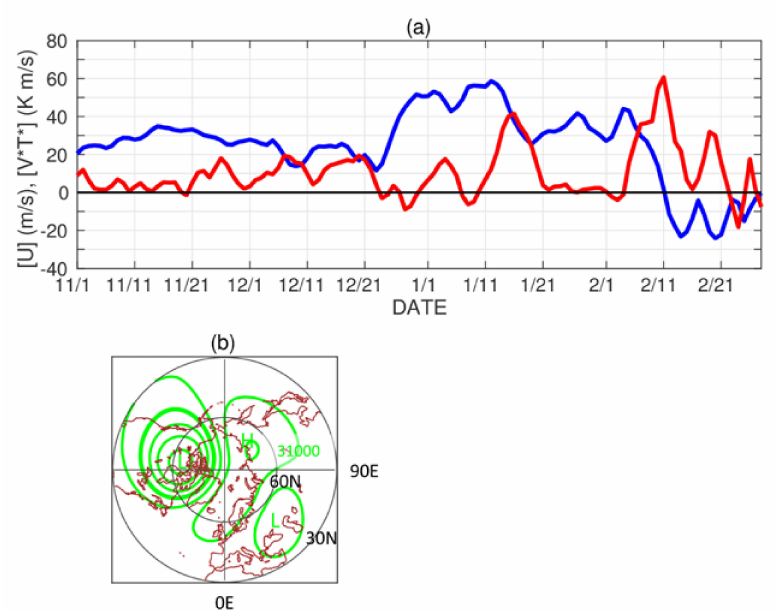
Figure 1. ( a ) Time series of the zonal mean zonal wind [U] at 60 ◦ N, 10 hPa (blue), and waves 1–3 poleward heat flux [V*T*] in 40–90 ◦ N, 100 hPa (red) in the JRA-55 data. Panel ( b ) plots the 10 hPa geopotential height in the JRA-55 data averaged for 5 days ( ± 2 days) around the major sudden stratospheric warming (MSSW) onset date of 12 February. Thick contour is for 30,000 m, and the contour interval is 500